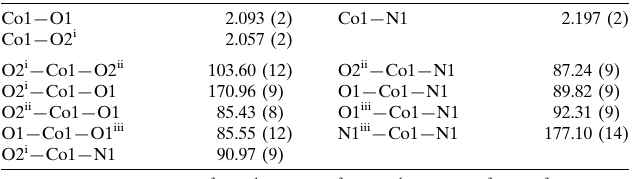
Selected geometric parameters (A˚ , (cid:3)